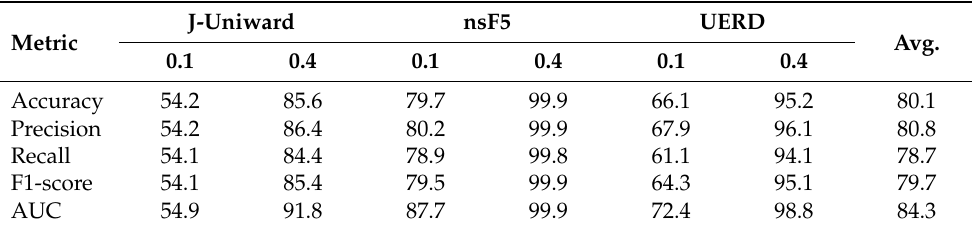
Table 3. Results of image steganography detection (in percentages) for the best shallow method (linear regression).